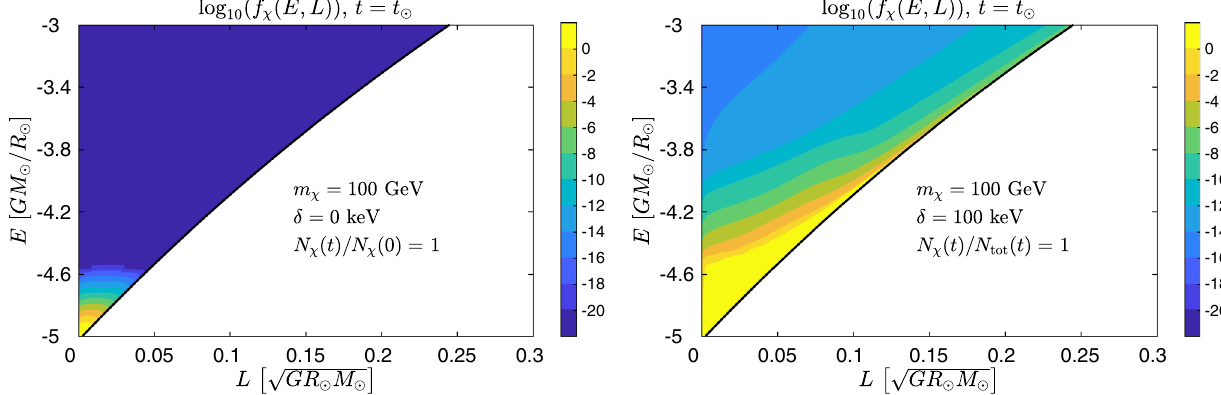
Fig. 8 The base 10 logarithm of the dark matter distribution at t = t (cid:9) , with an initial distribution given by the capture rate. We use m χ = 100 GeV. Left panel: Elastic scattering. Right panel: Inelastic scattering with δ = 100 keV